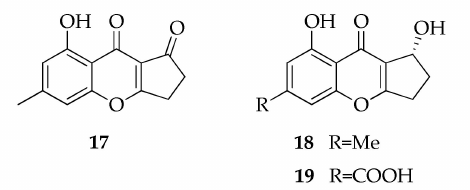
Figure 5. Structures of benozopyranones.